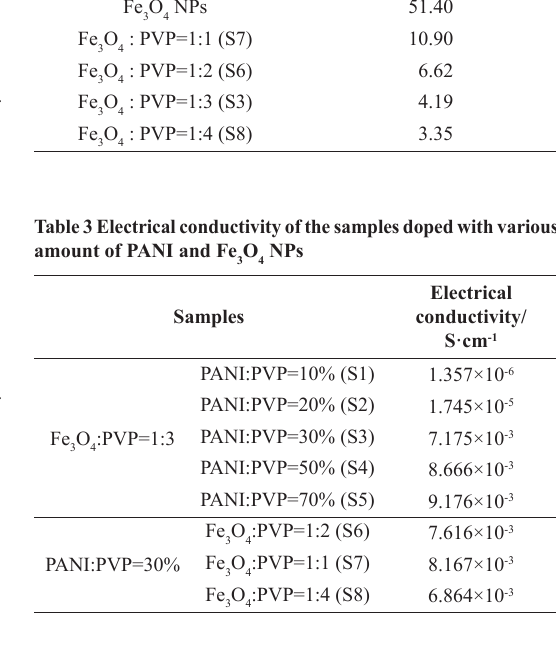
Fig. 4 Hysteresis loops of Fe composite nanofibers with various ratios of Fe O /PVP 3 4 Table 2 Saturation magnetization of Fe composite nanofibers